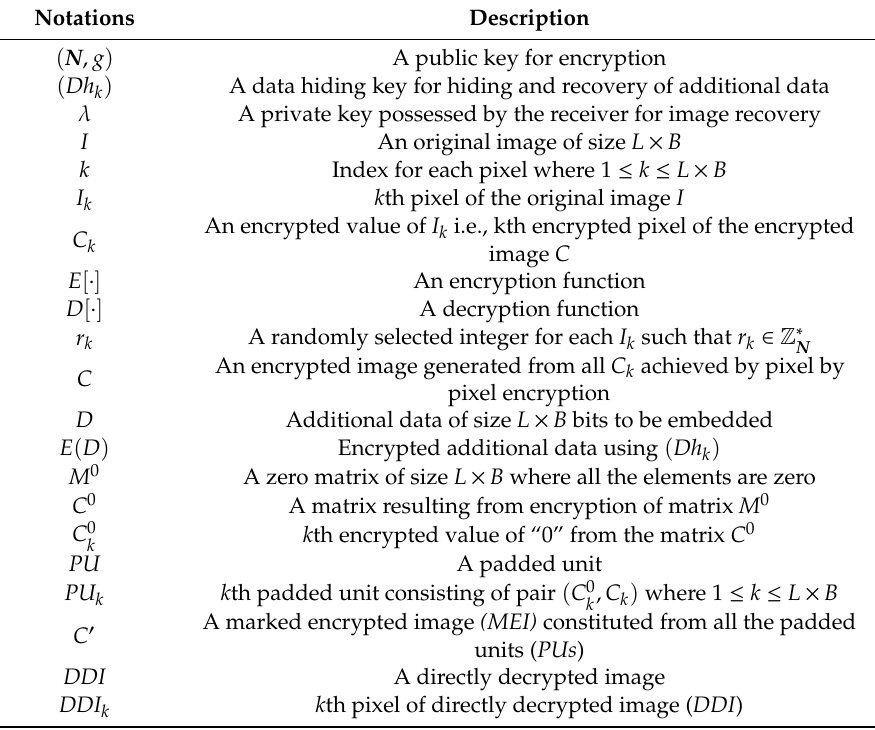
Table 1. Key notations used in the proposed scheme.